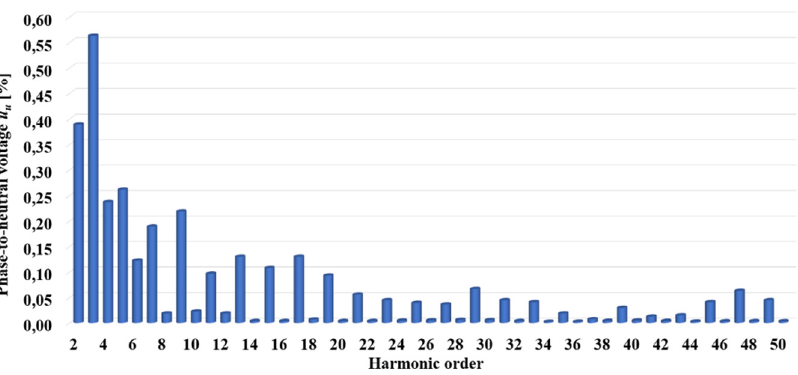
Figure 21. Harmonic spectrum of the phase-to-neutral voltage u u .